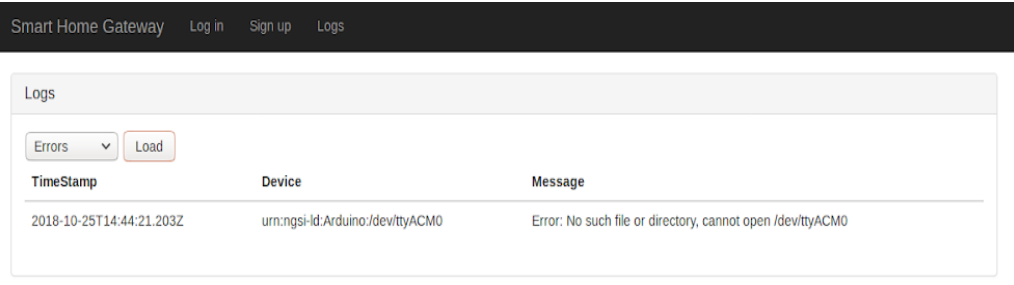
Figure 6. Undetected sensor in the log.